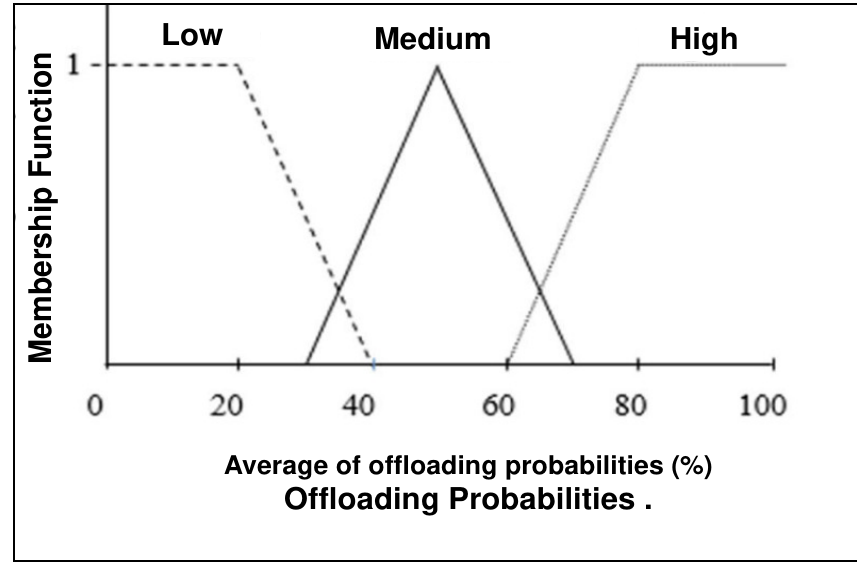
Figure 4. The probability of